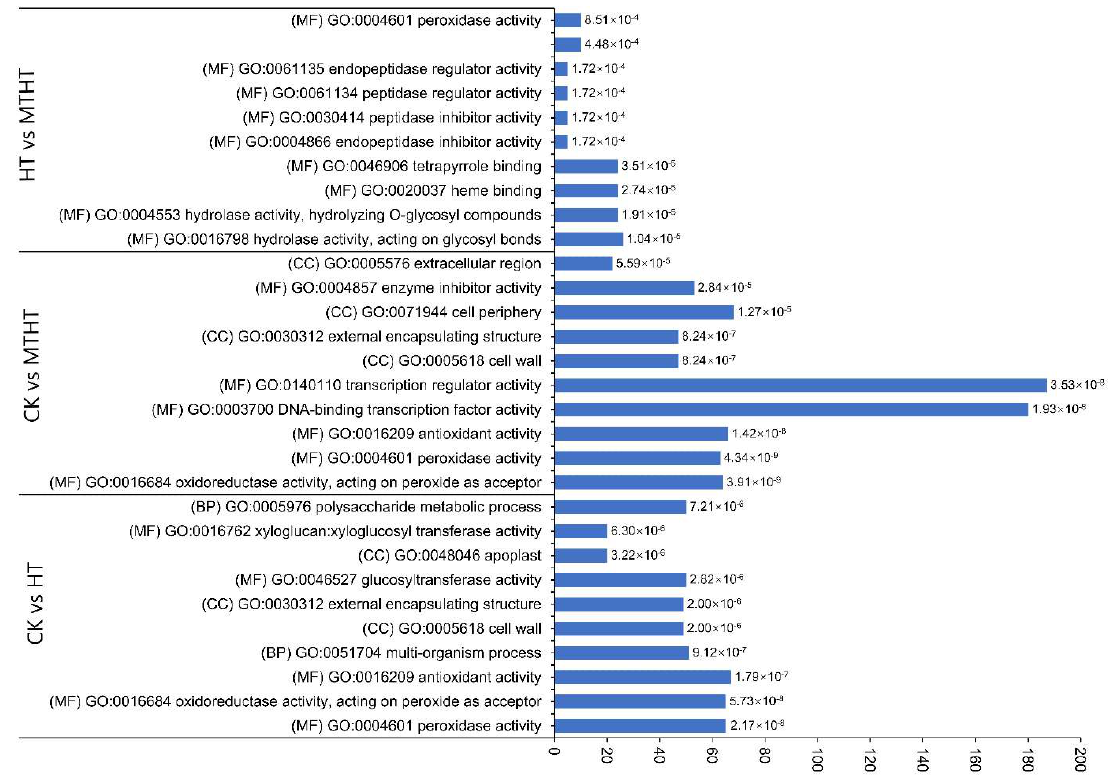
Figure 5. Gene Ontology (GO) enrichment analysis of DEGs among comparison pairs. The top 10 enriched terms with highly significant p -values (≤0.05) in each comparison are represented. The values of the false discovery rate are shown in the bar graph. (BP): biological process; (MF): molecular function; (CC): cellular component.